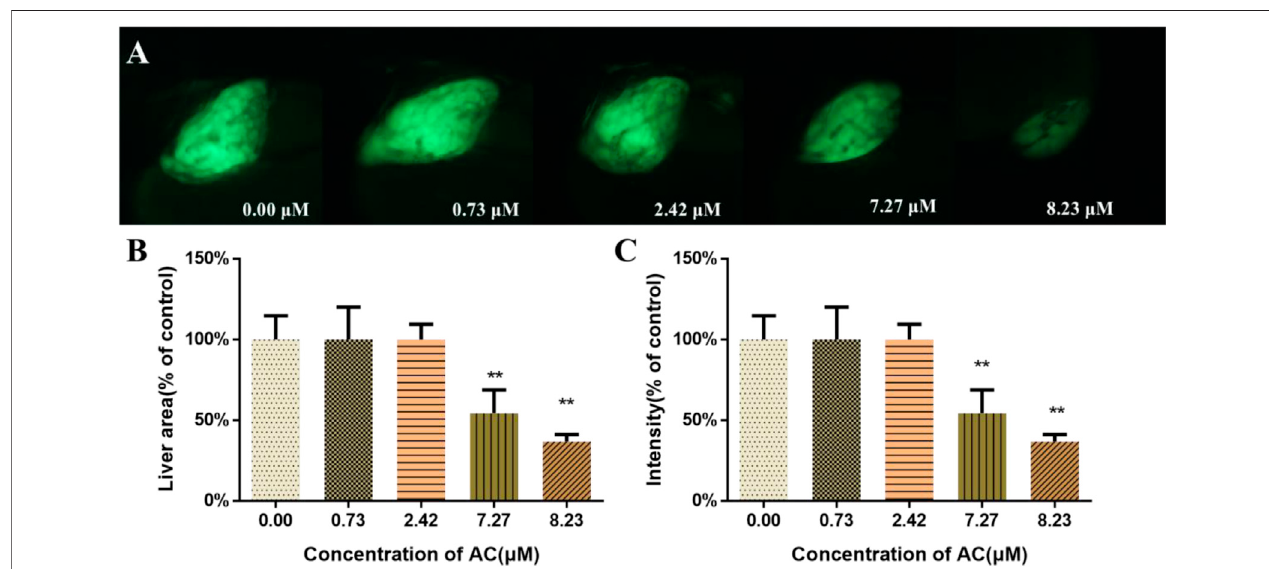
FIGURE 3 | Effects of AC on developing liver. (A) The lateral view images of developing livers of Tg(L-FABP:EGFP) zebra fi sh embryos, which express a green fl uorescent protein ( GFP ) in the liver at 96 hpf. (B) Liver area of embryos at 96 hpf. (C) The liver intensity of embryos at 96 hpf. The values are expressed as mean ± SD ( n (cid:1) 10). * p < 0.05 and ** p < 0.01 vs.